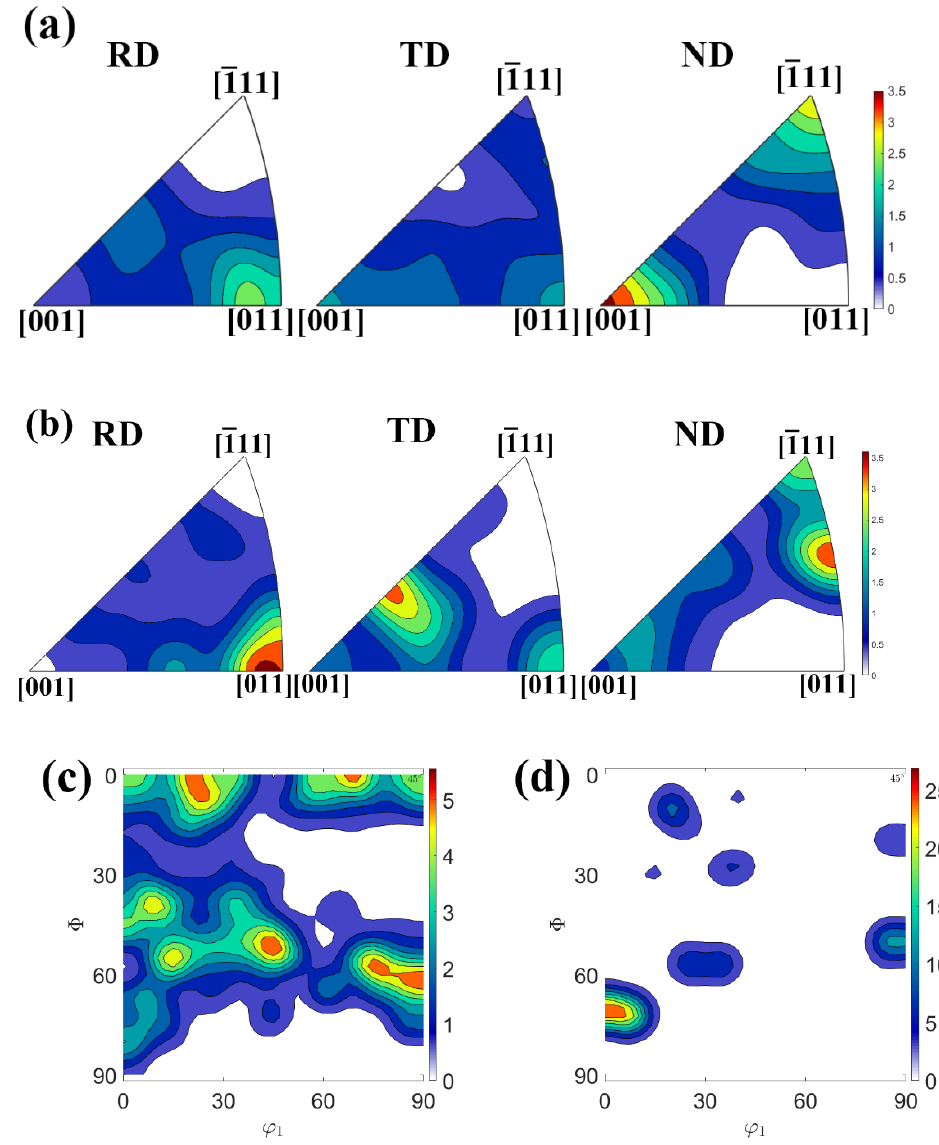
Figure 17. The IPFs (top) and ODFs (bottom) of the molten zone of the rolled sample ( a , c ) and fully recrystallized samples ( b , d ) at 0.64 GW/m 2.